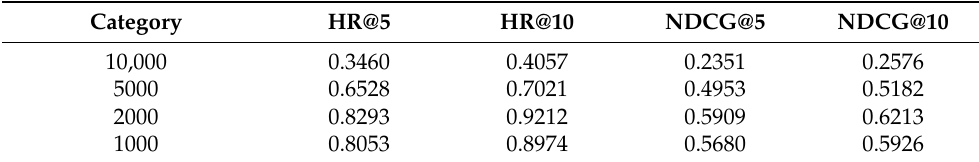
Table 7. The result of different values of the category in the school borrowing data. Category HR@5 HR@10 NDCG@5 NDCG@10 10,000